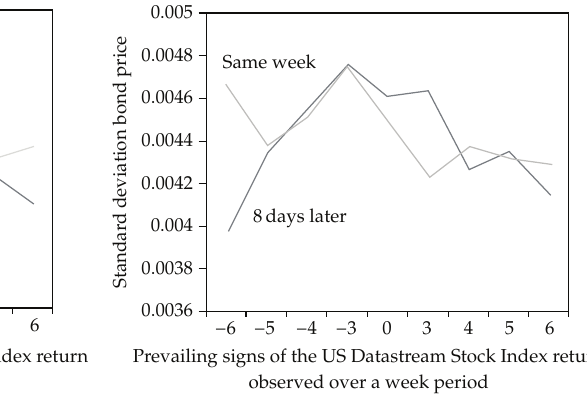
Figure 13: The figure shows the dependency of the standard deviation of given returns from a “consensus” variable, which sums up the prevailing sign on a period of 6 days observed on the daily return series of the Datastream US Stock Index. We call prevailing sign that most frequently observed on a given number of returns. The cases of − 3 and 3 verify when a period of 6 days reduces to 5 due to, for example, a market close. The case of 0 is that of no prevailing sign. (cid:3) a (cid:6) shows the weekly standard deviation of the daily returns of the Datastream US Stock Index. (cid:3) b (cid:6) shows the weekly standard deviation of the returns calculated on the daily price of the 25yrs. Treasury bond issued on september